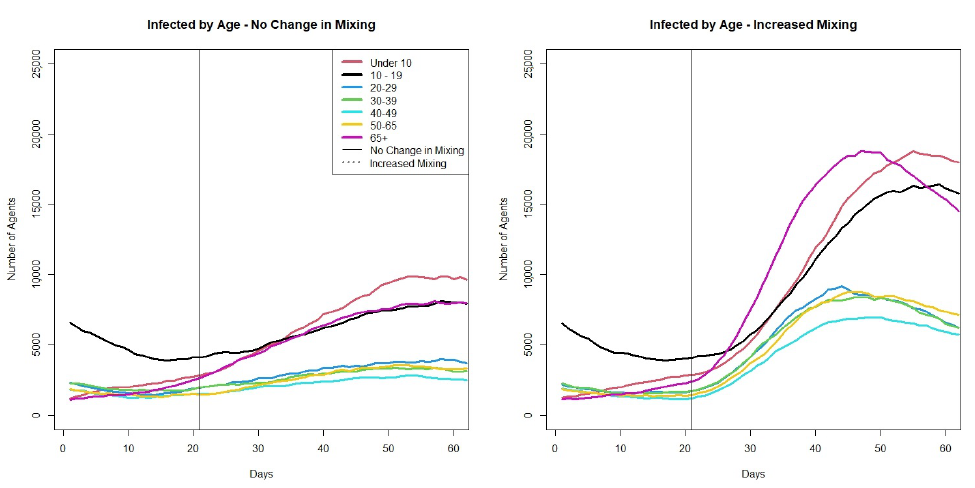
Figure 8. Plots showing average number of infectious agents at a given time based on their age across 30 runs of the two